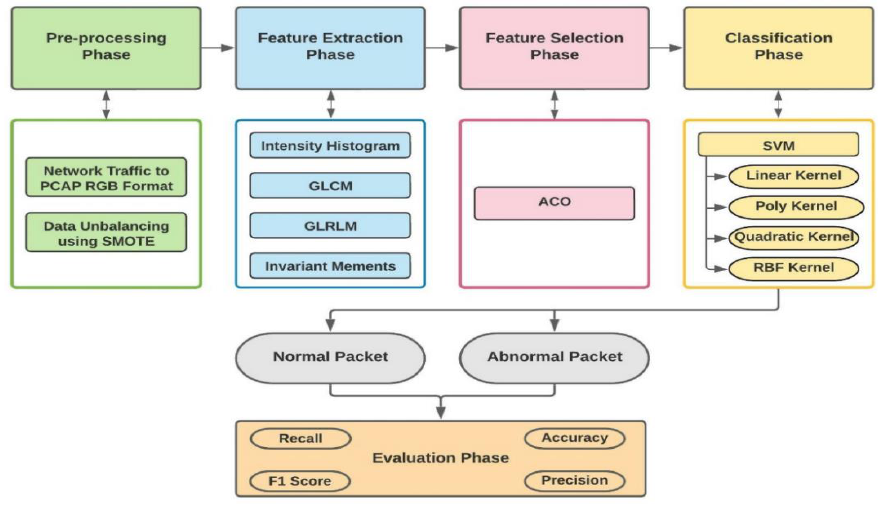
Figure 2 . Image-based IoT malware detection using machine learning . Figure 2. Image-based IoT malware detection using machine learning.